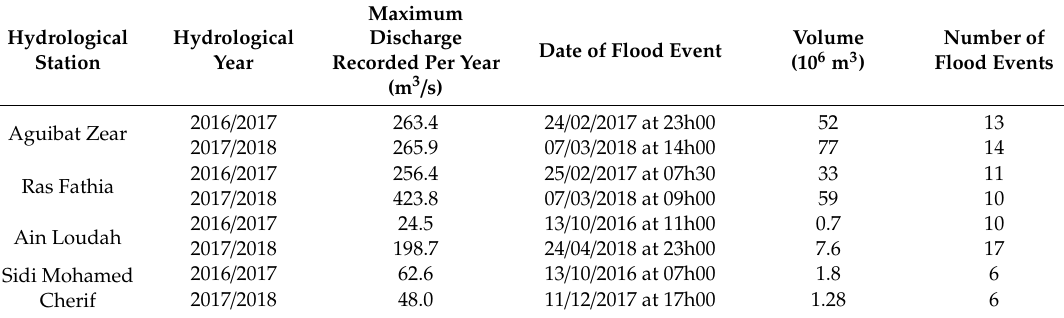
Figure 3. Mean monthly discharges at the hydrological stations studied.